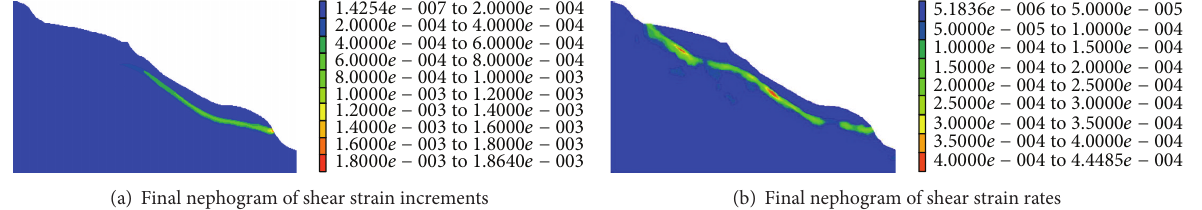
Figure 17: Nephogram of shear strain increments and shear strain rates of the slope after five earthquakes.